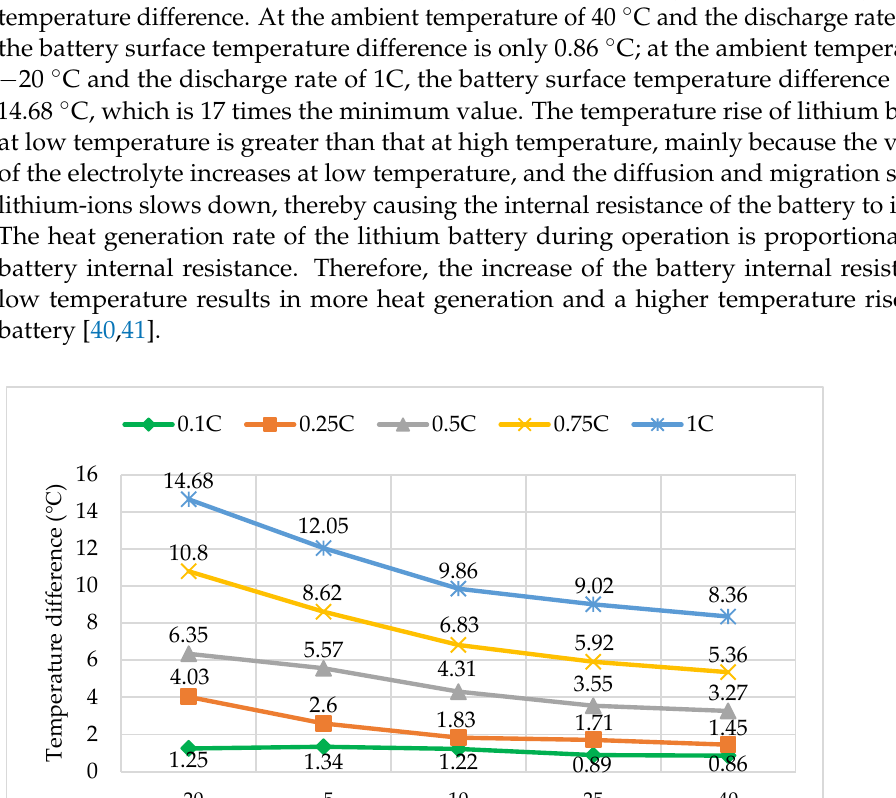
Figure 16. The voltage variation interval diagram of the voltage plateau period during 1C discharge.